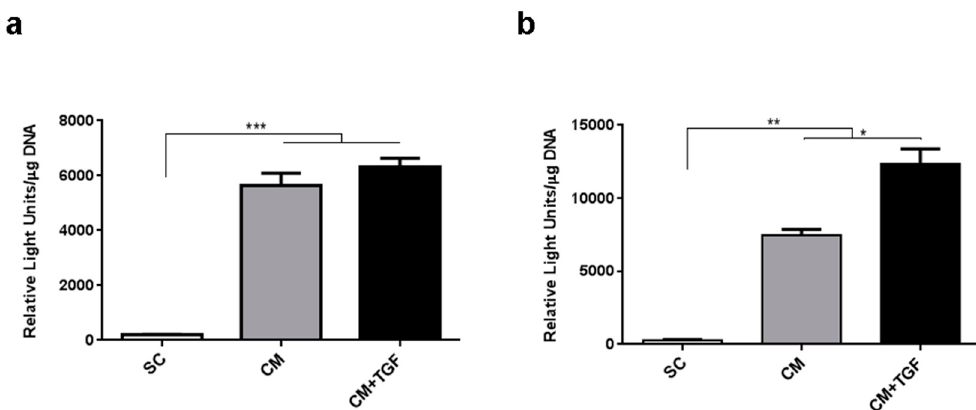
Figure 2. Collagen 2 reporter activity in MSC cells following 14-day chondrogenic treatment in either 2D monolayer ( a ) or 3D micromass format ( b ). Error bars represent the standard error of the mean ( n = 3). * p < 0.05, ** p < 0.01, *** p < 0.001. SC: Standard Culture medium, CM: Chondrogenic differentiation medium, CM + TGF: chondrogenic medium supplemented with TGF- β 1.